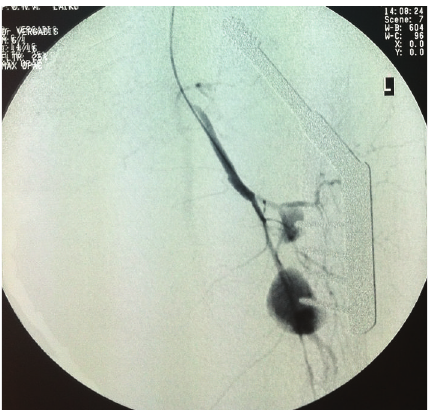
Figure 1: Hemorrhage fed by two perforating arteries, located at the tips of the first and fourth screws.